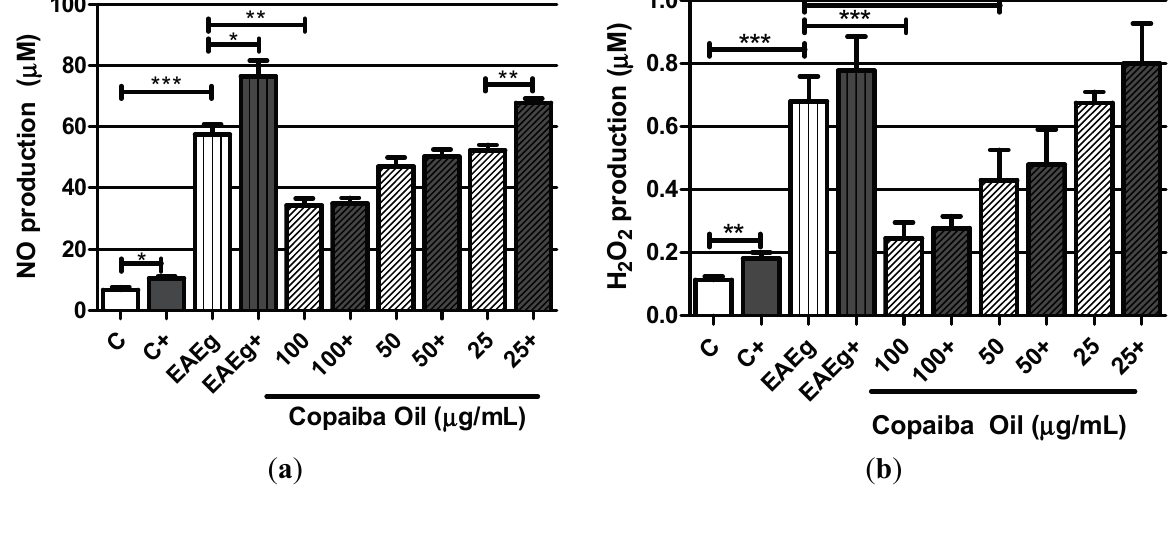
O ( b ), by mouse splenocytes Figure 2. Oxygen radicals production, NO ( a ) and H 2 2 incubated with copaiba oil (100, 50 and 25 μ g/mL). Mouse splenocytes from non-immunized and untreated mice were used as negative control group (C) and splenocytes from EAE-mice were used as EAE control group (EAEg). Groups presented as (+) were also . After incubation, supernatants were collected and stimulated with ConA and MOG 35–55 O and NO were measured. Data are presented as mean ± SD. * P < 0.05; ** P < H 2 2